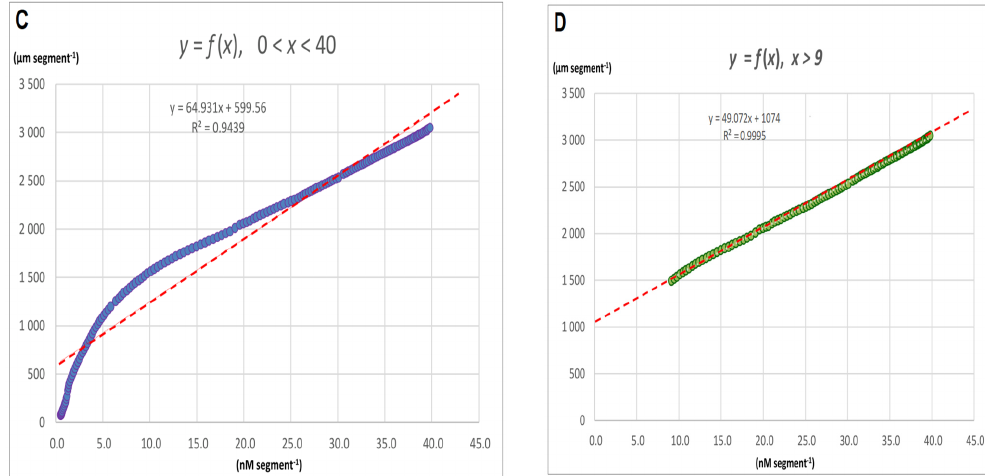
Figure 2. Kinetics of the medium pH changes of the coleoptile segments that had been incubated in the presence of 10 − 7 , 10 − 6 and 10 − 5 M of FC ( A ), the dose–response curves for the FC (10 − 9 –10 − 5 M)-induced medium pH changes (expressed as changes in the H+ concentration per coleoptile segment, nM segment − 1 or nM cm − 1 ) of the coleoptile segments as a function of time ( B ), and correlation between elongation (µm segment − 1 ) and proton extrusion (nM segment − 1 ) for two time inter- vals; the first, from the addition of FC to the end of the experiment (120–600 min) (0 < x < 40) (C), and the second starting 30 min later (150–600 min) (x > 9) (D) . In the second time interval, the FC-induced rapid growth was omitted. The inset in Figure 2A shows the proton extrusion, which was expressed as the changes in the H + concentration per coleoptile segment. The coleoptile segments were first preincubated (over 2 h) in the control medium to which FC was added (arrow). The pH values are the means of at least five independent experiments that were performed simultaneously with growth (shown in Figure 1) using the same tissue samples. Bars indicate ± SE.